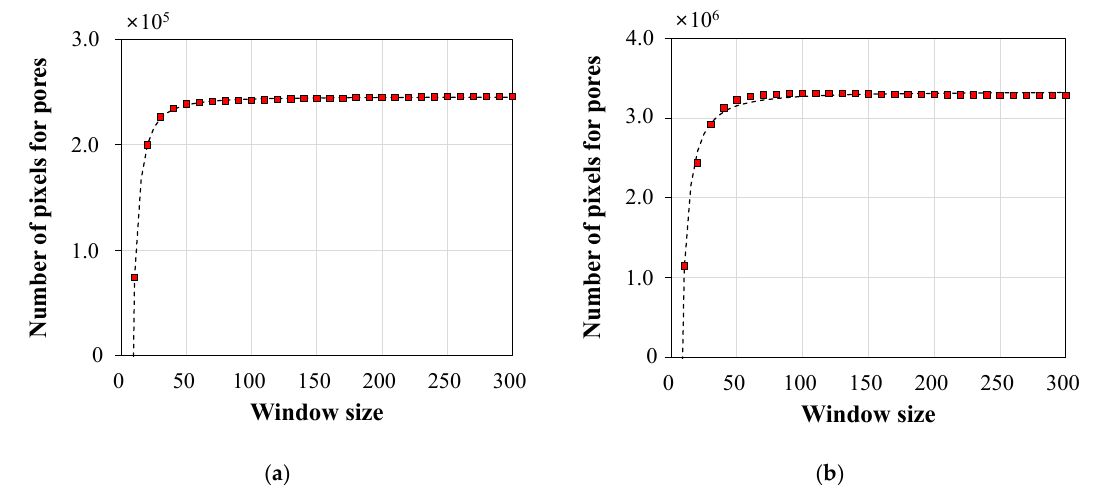
Figure 4. The relationship of the number of pixels designated as pores with the window size: ( a ) PCM1-1 and ( b ) PCM3-3.